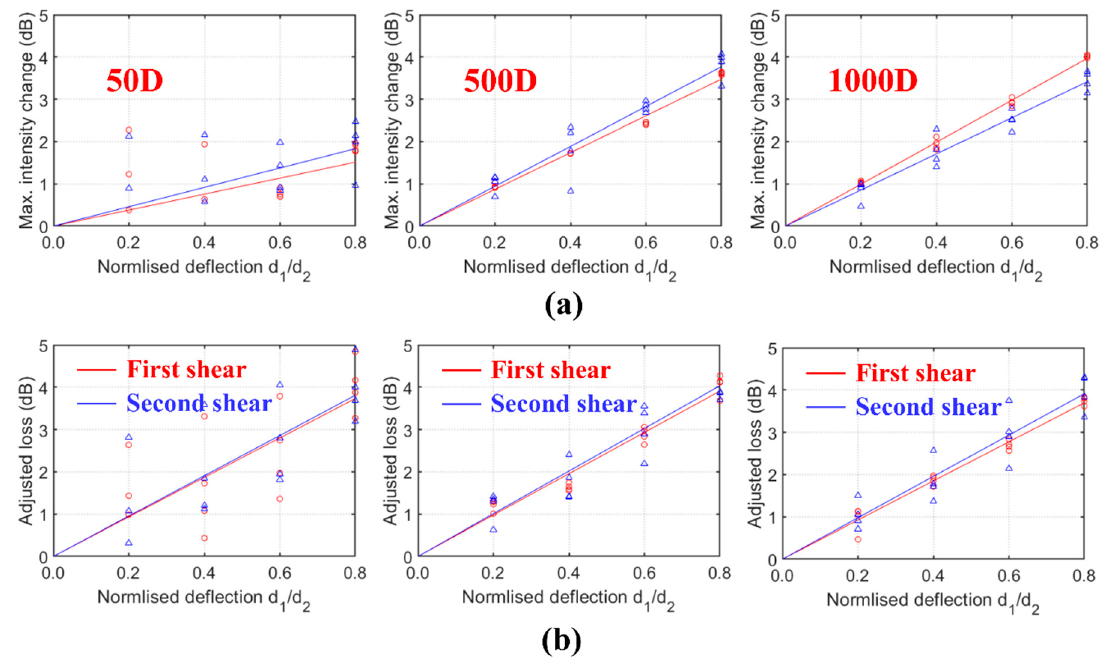
Figure 10. Correlations between shear deflections with ( a ) maximum intensity change due to reflection and ( b ) loss of individual shear events ( ∆ = measured properties of the second shear events and ○ = measured properties of the first shear events).